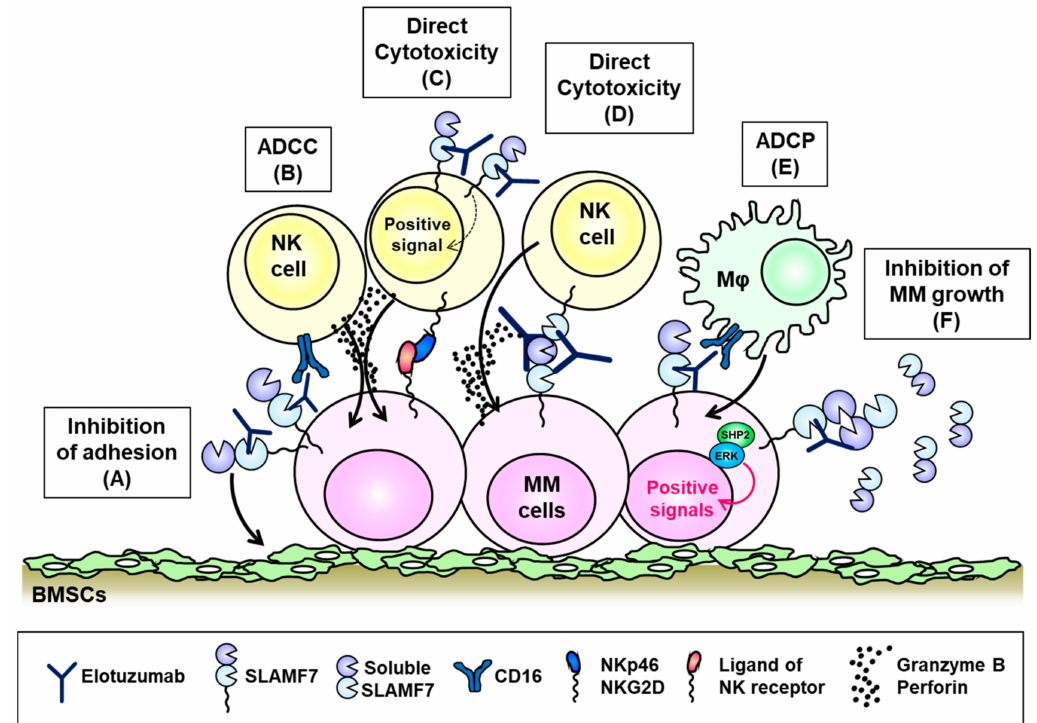
Figure 4. The biological function of the signaling lymphocytic activation molecule family receptor (SLAMF) 7 on multiple myeloma (MM) cells and mechanism of action of elotuzumab. ( A ) On MM cells, SLAMF7 is associated with adhesion to bone marrow stroma cells (BMSCs) and elotuzumab blocks MM cell adhesion to BMSCs. Elotuzumab stimulates robust natural killer (NK) cell-mediated antibody-dependent cell-mediated cytotoxicity (ADCC) via the Fc–CD16 interaction ( B ), directly induces activating signal transduction in NK cells ( C ), improves NK-cell-mediated cytotoxicity in response to the SLAMF7–SLAMF7 interaction ( D ), and enhances macrophage (M ϕ )-mediated antibody-dependent cellular phagocytosis through the CD16 receptor ( E ). ( F ) SLAMF7 promotes MM cell growth via SHP2–ERK signaling in response to binding with soluble SLAMF7 (sSLAMF7), and elotuzumab suppressed MM cell growth promoted by SLAMF7–sSLAMF7 interactions in